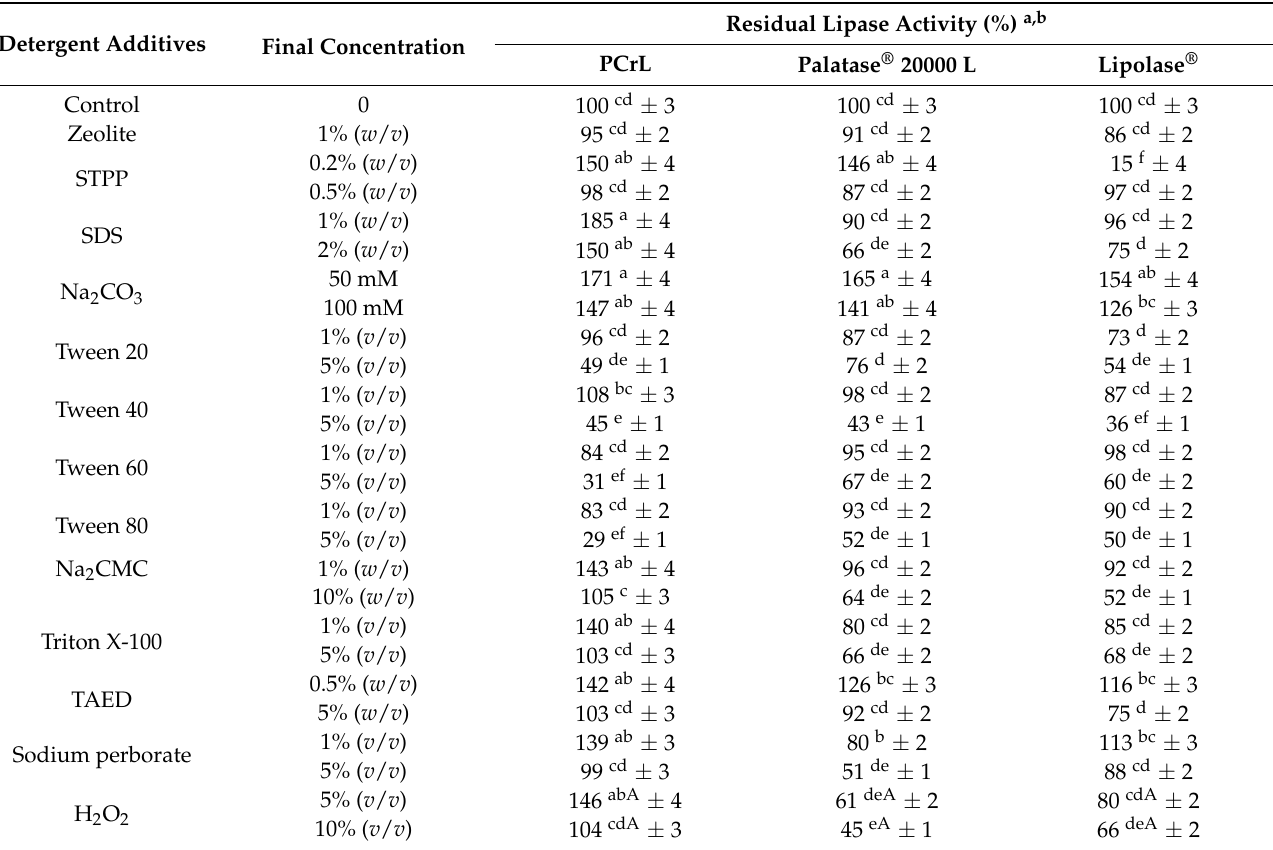
Table 4. Stability of alkaline lipases PCrL, Palatase ® 20000 L, and Lipolase ® with several detergent additives. Detergent Additives Final